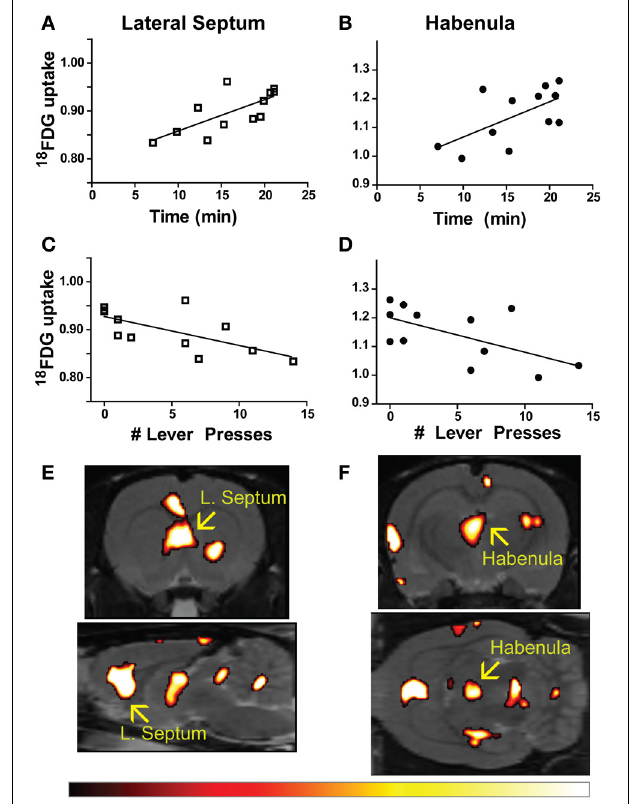
FIGURE 2 | Brain-behavior correlations in learned helplessness. (A–D) Time to finish the test (A,B) and number of lever presses within 20s of shock onset (C,D) correlated with metabolic activity in the lateral septum (time: r = 0 . 7131, p = 0 . 0092; lever: r = − 0 . 6692, p = 0 . 0173), and habenula (time: r = 0 . 6138, p = 0 . 0338; lever: r = − 0 . 6060, p = 0 . 0367). (E,F) Metabolic activity correlating with time to finish the test visualized with a voxel-by-voxel one sample t -test ( p < 0 . 05), arrows designate the lateral septum (E) and habenula (F) as bright areas overlaid on the T2-weighted rat template using the hot color scale (shown